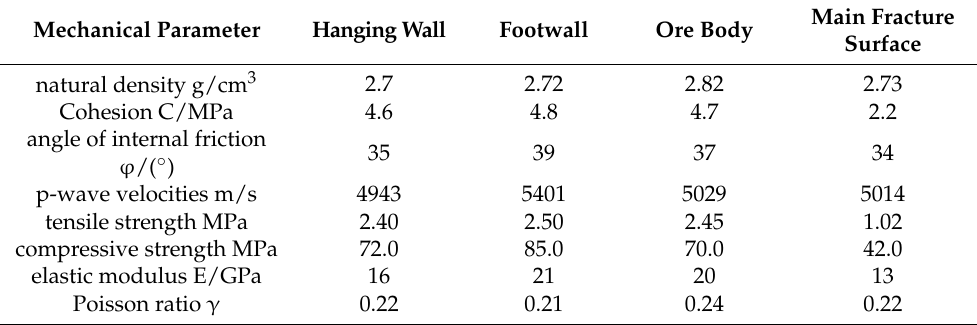
Main Fracture Surface